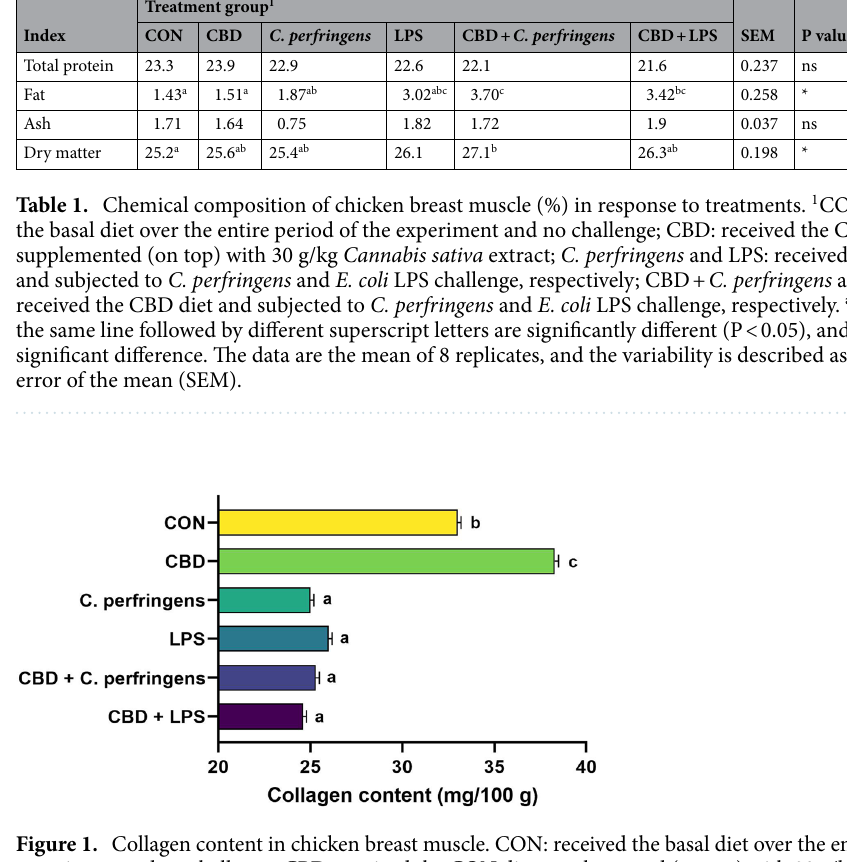
Figure 1. Collagen content in chicken breast muscle. CON: received the basal diet over the entire period of the experiment and no challenge; CBD: received the CON diet supplemented (on top) with 30 g/kg Cannabis sativa extract; C. perfringens and LPS: received the CON diet and subjected to C. perfringens and E. coli LPS challenge, respectively; CBD + C. perfringens and CBD + LPS: received the CBD diet and subjected to C. perfringens and E. coli LPS challenge, respectively. a–c Different letters indicate significant differences (P < 0.001). The error bars indicate the standard error values for the 8 chickens in each treatment